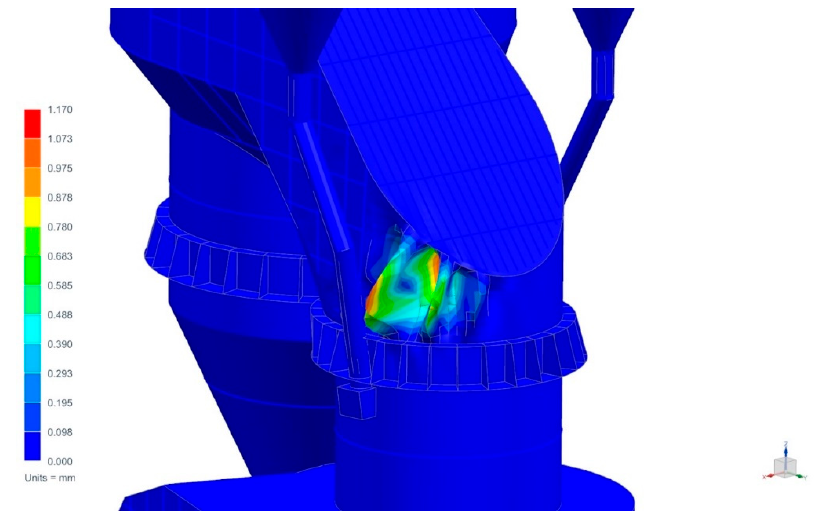
Figure 17. The stress pattern for the analysis accounting measured hotspots, von Mises stresses. The locations of this region is the area where the cylindrical part of the structure connects with the material transportation channel. At this place, the geometry changes significantly.